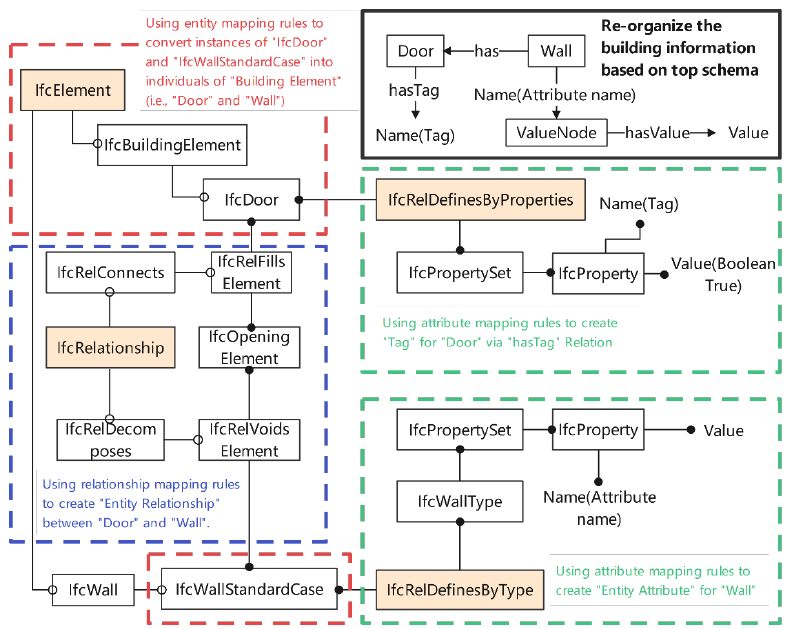
Figure 7. Examples of mappings between the IFC EXPRESS schema and the proposed top schema.